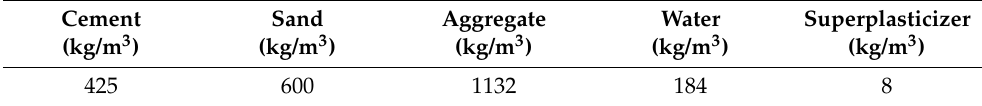
Table 1. Mix proportions of concrete